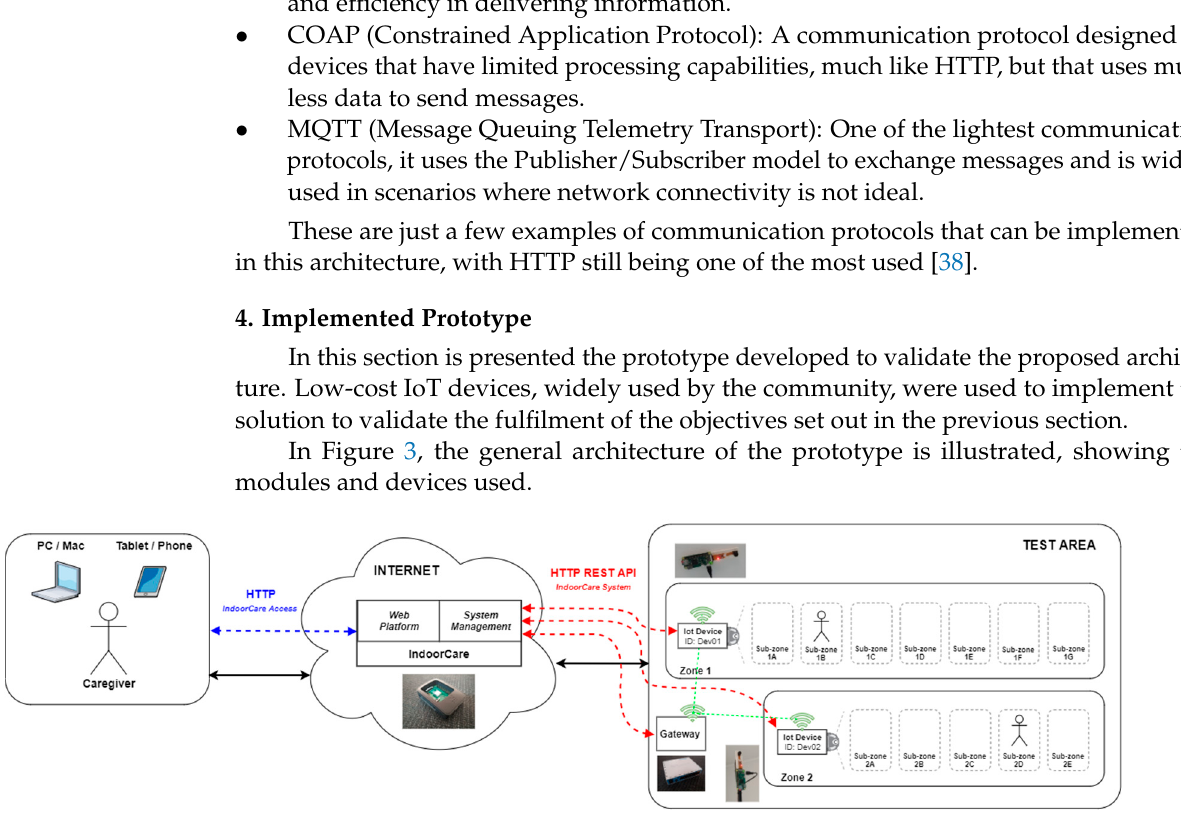
Figure 3. Prototype conceptual architecture.